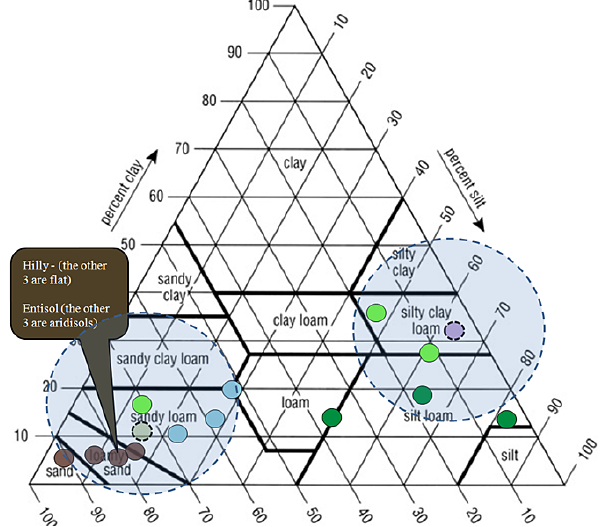
Figure 12. The 15 SCAN sensors, color-coded to match their hy- droclimatic class, with similar soil textures shaded.